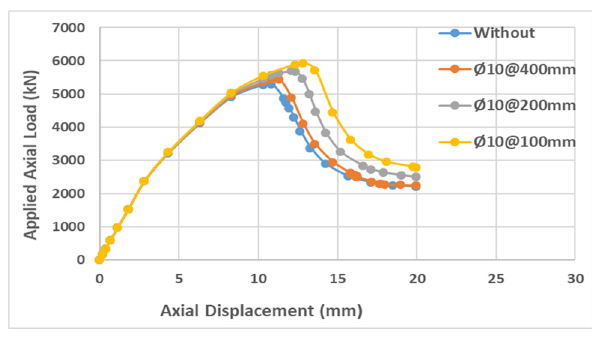
Figure 9: Numerical load - vertical displacement of RC column with di ff erent spacings of ties at 20°C.